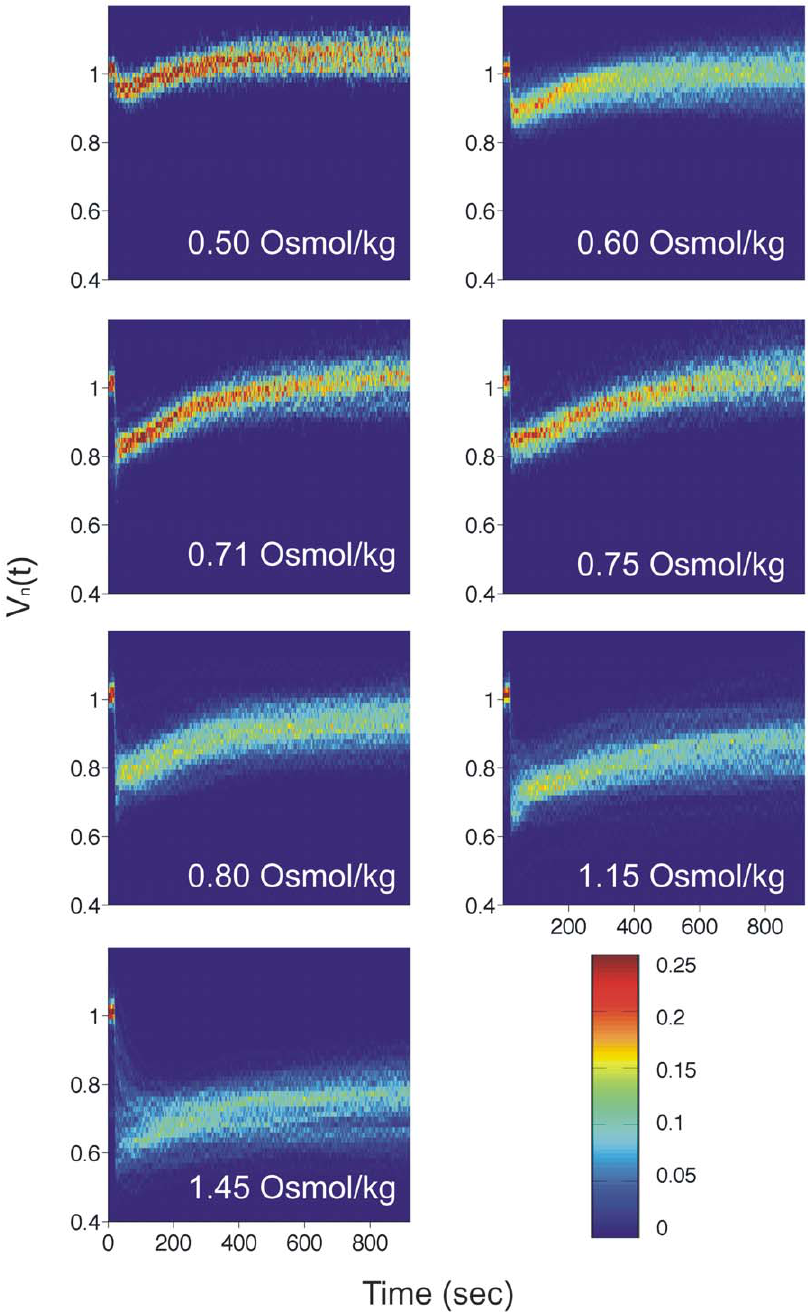
Figure 4. 2D Probability density function (PDF) of the recovery traces for a given shock magnitude. Approximately 100 cells per shock magnitude are includes. PDFs are calculated from normalized and aligned data sets as in Figure 3. Cells were shocked by transferring them from LB into LB and a given amount of sucrose. Post shock osmolality is given in each panel. doi:10.1371/journal.pone.0035205.g004 rate of volume reduction is , 10% per second and that during this initial shrinking the inner membrane is not detached from the cell wall. This phase of volume reduction lasts for , 5 seconds and the E.coli Aquaporin Z protein is not required for fast water efflux.